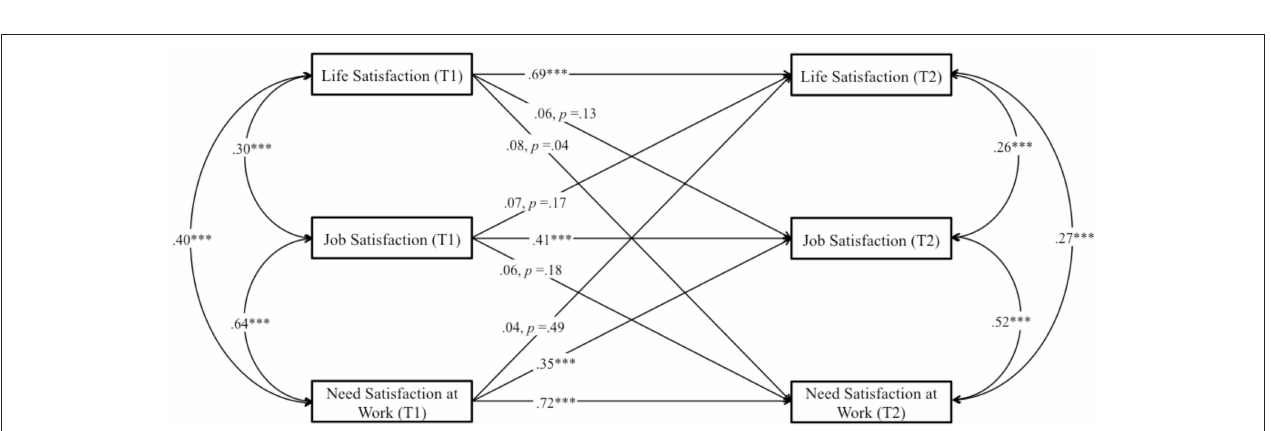
FIGURE 4 | Study 2. Structural longitudinal model for the association between job satisfaction and life satisfaction, and need satisfaction at work. Coefficients shown are standardized paths. Error terms are not shown to enhance visual clarity. T1, Ti me 1; T2, Time 2. *** p < 0.001.